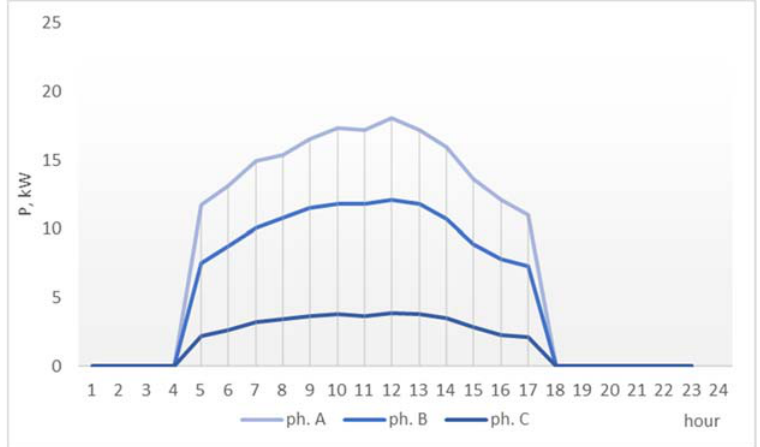
Figure 7. Generation in network R28.